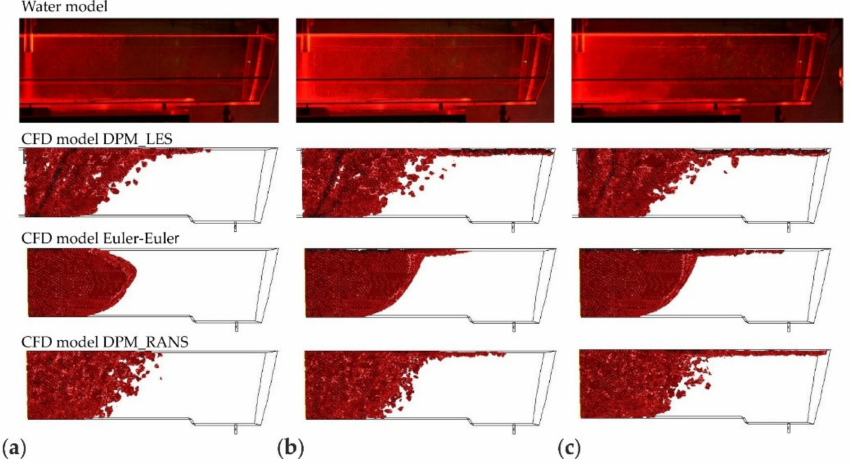
Figure 11. The location of the microparticles (fraction 140 µ m) in the tundish model for a duration of, respectively: ( a ) 25, ( b ) 60, ( c ) 120